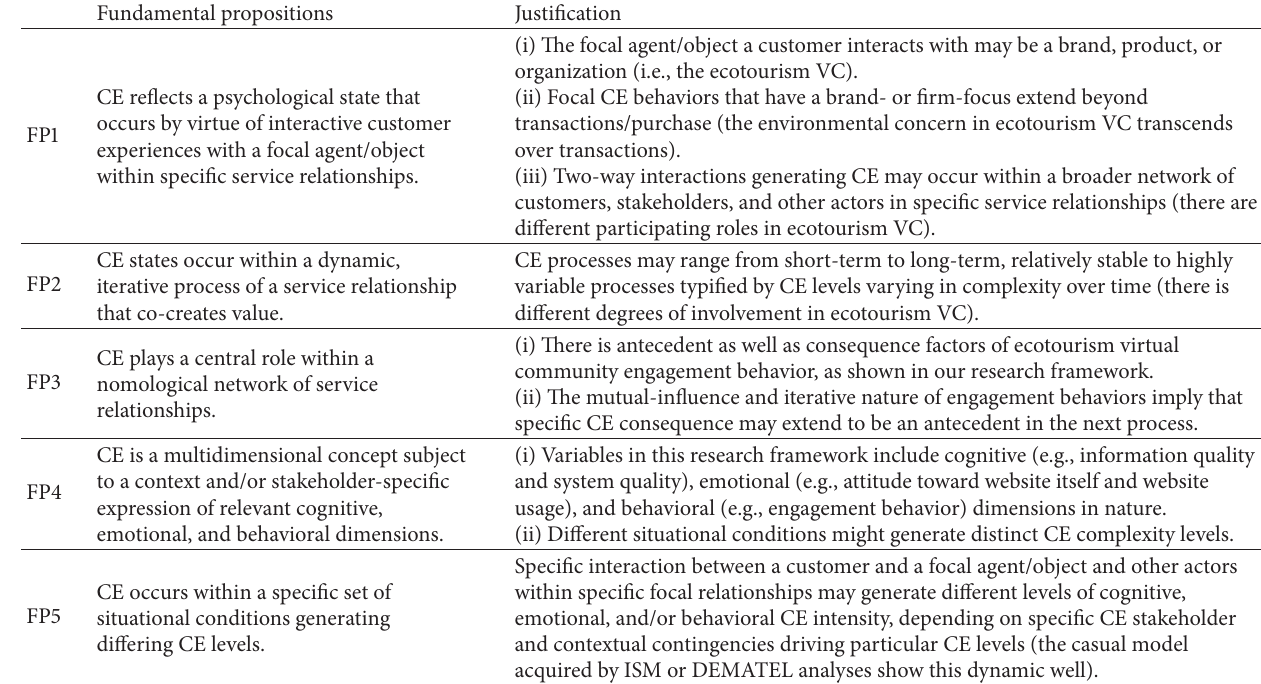
Table 11: The justification of research results on FP of CE.